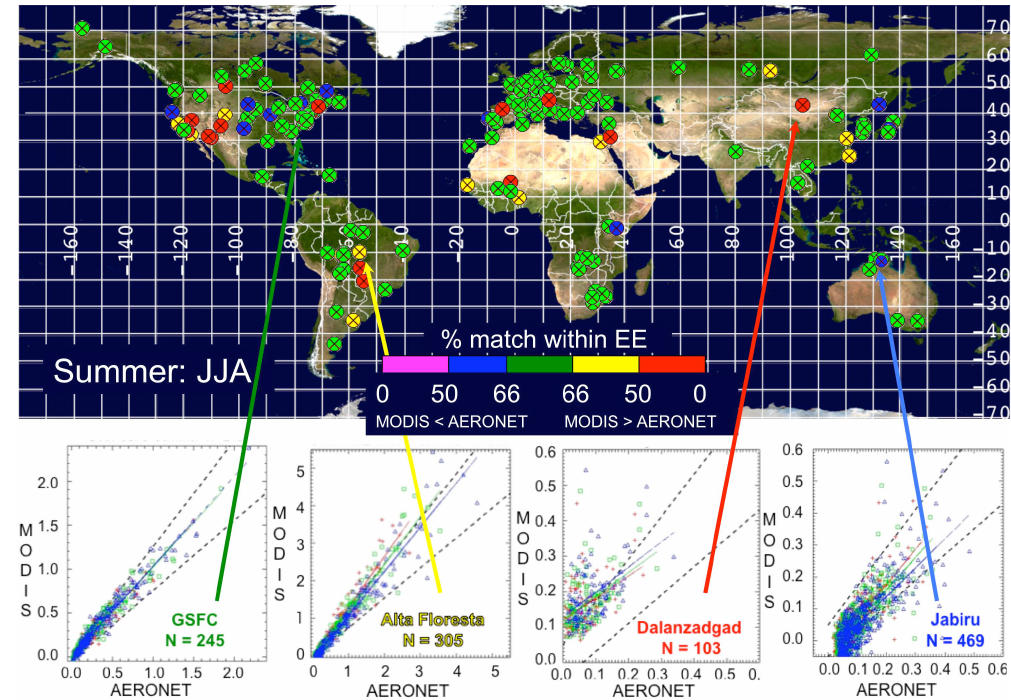
Fig. 4. “Quality” of Terra-MODIS/AERONET comparisons of total AOD over land at each site, from the union of Terra and Aqua, during June–July–August. The color at each represents the “quality” of the comparison at 0.55µm, designated as the percentage of the collocations that fall within EE (Table 3). The comparisons of spectral AOD (different symbols: blue – 0.47µm, green – 0.55µm, red – 0.65µm) at four sites are plotted, including: GSFC (38 ◦ N, 76 ◦ W), Alta Floresta (9 ◦ S, 56 ◦ W), Dalanzadgad (43 ◦ N, 104 ◦ E) and Jabiru (12 ◦ S, 132 ◦ E). The dotted lines for each scatterplot are the EE ± (0.05+0.15) over